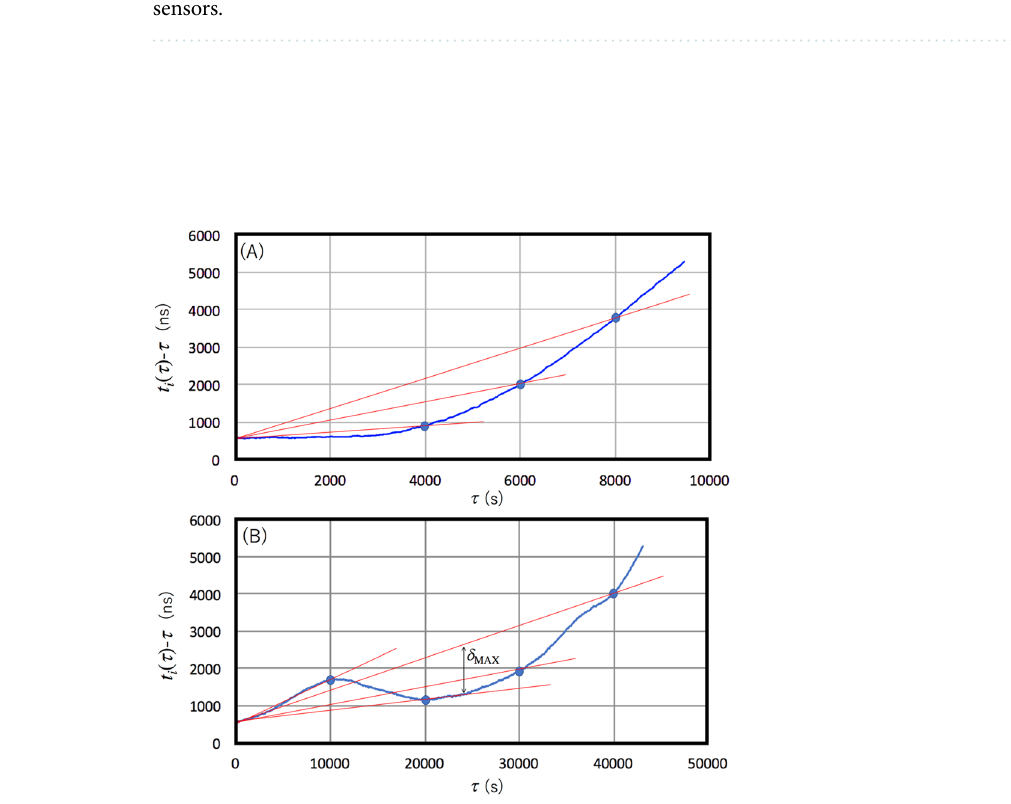
Figure 9. Drift curves measured with Trimble Thunderbolt GM200 OCXO (blue curves). The first ( A ) and second ( B ) strongest drift curves among 12 runs. Red lines indicate linear interpolations between blue filled circles. The maximum deviation between these red lines and the blue curves defines δ MAX